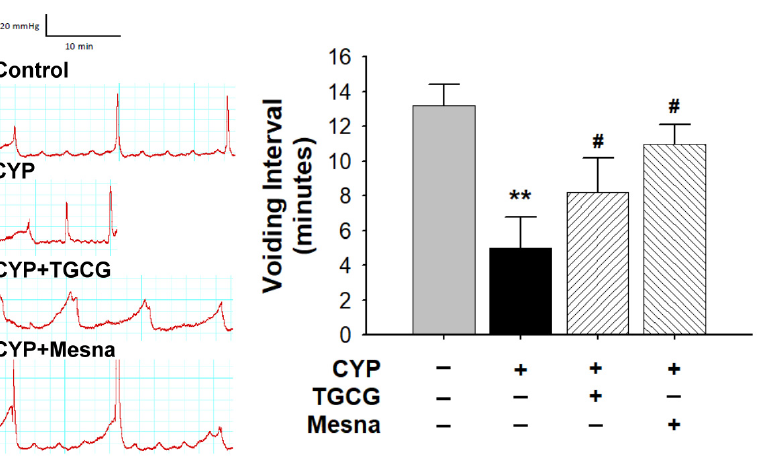
Figure 1. Cystometry traces between group 1—saline-injected control, group 2—CYP + placebo with normal saline, group 3—CYP + TGCG (200 mg/kg), and group 4—CYP + Mesna (30 mg/kg). In the cystometry assay, the peaks signify the detrusor contraction. Voiding interval values were presented in the different groups. Each bar in the figure denotes the mean ± standard deviation. ** p < 0.01 contrasted to control group. # p < 0.05 contrasted to CYP.